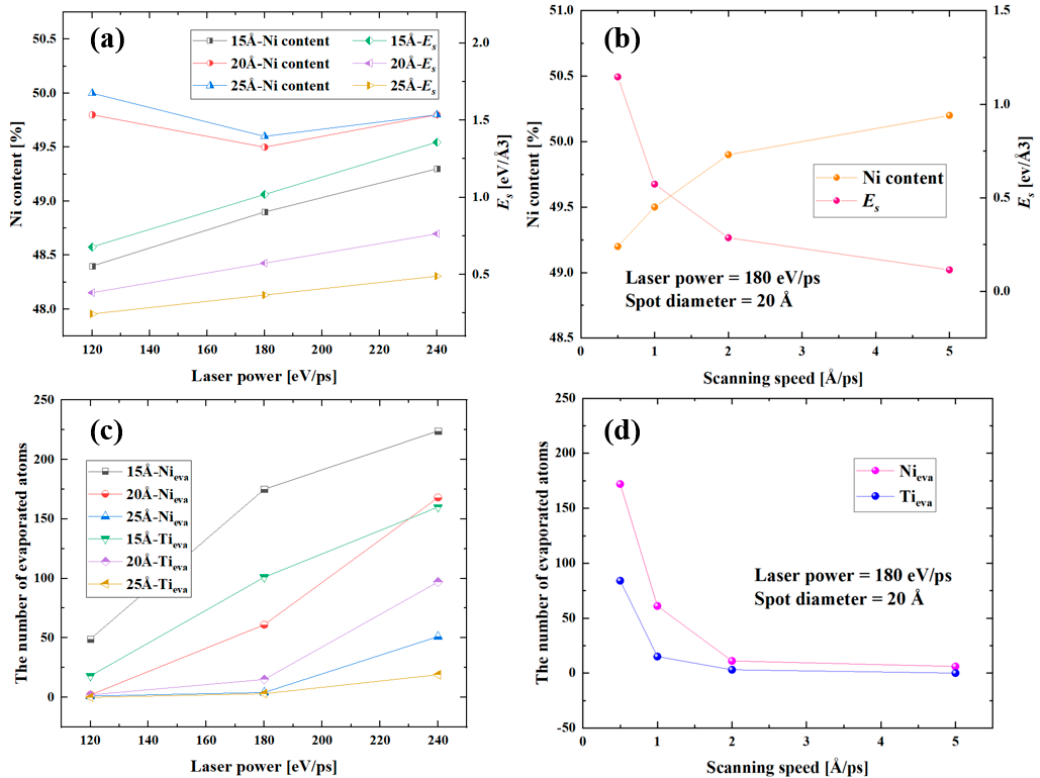
Figure 9. The influence of laser parameters on the Ni content in the molten pool and E s : ( a ) the effect of laser power and spot diameters on the Ni content and E s at the same scanning speed of 1 Å/ps. ( b ) the effect of the scanning speed on the Ni content and E s at the laser power of 180 eV/ps and a spot diameter of 20 Å. ( c ) and ( d ) the number of evaporated atoms correspond to ( a ) and ( b ), respec- tively.